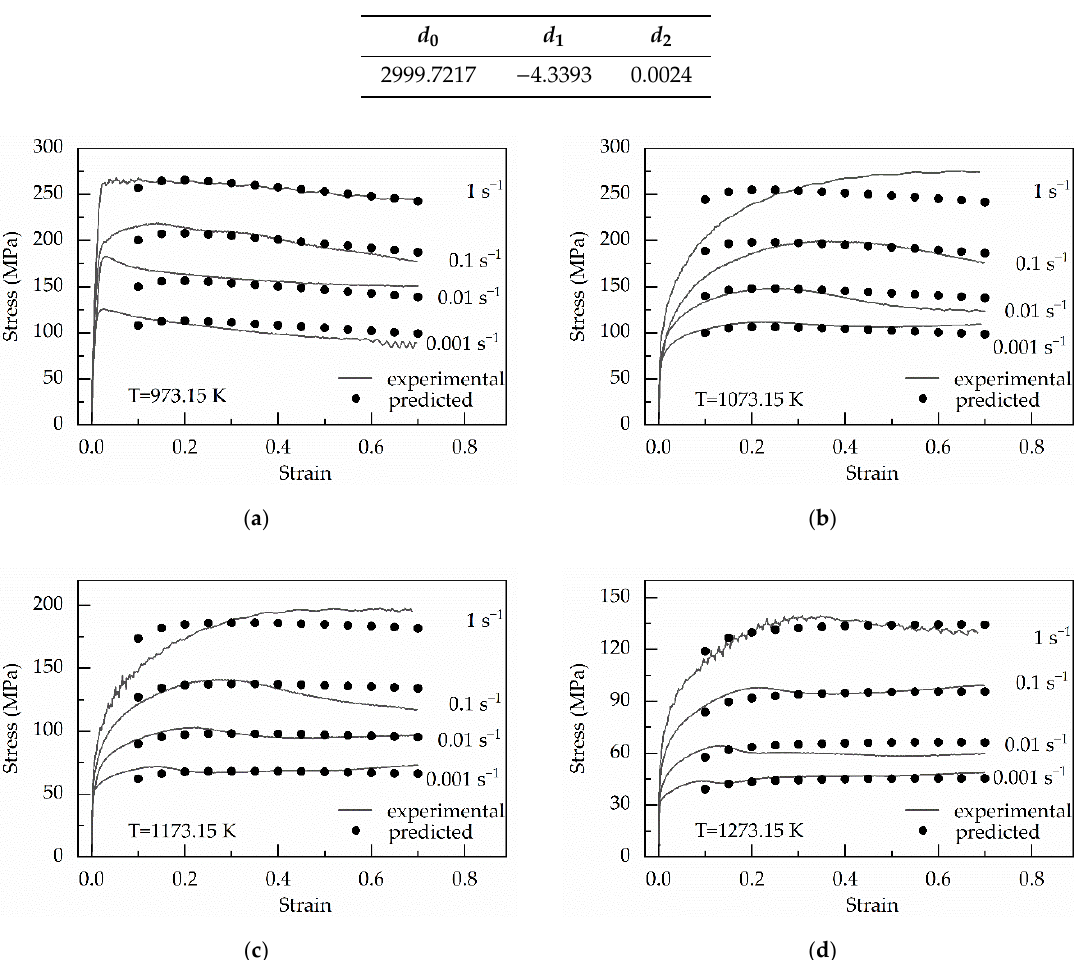
Figure 20. Comparison between the experimental and predicted stress by in the mHS equation at temperatures of ( a ) 973.15 K; ( b ) 1073.15 K; ( c ) 1173.15 K; ( d ) 1273.15 K.